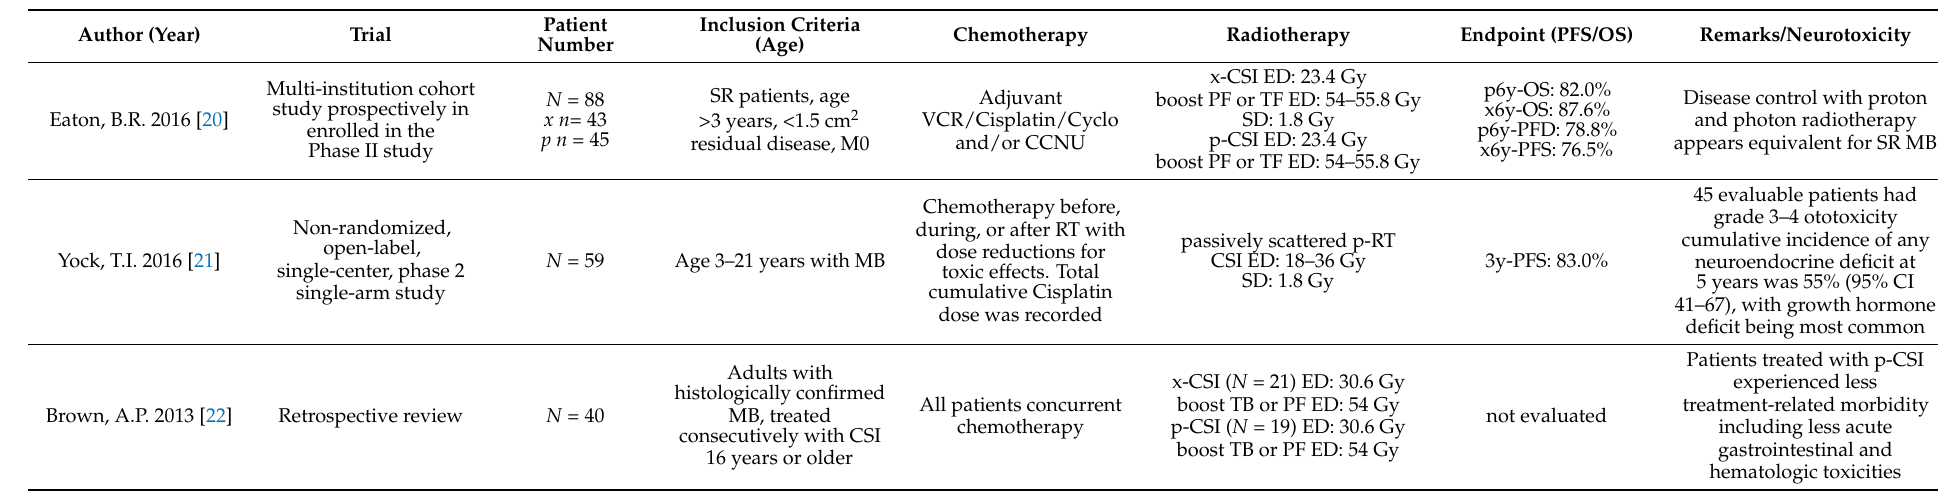
Table 2. Clinical trials and series applying proton radiotherapy in